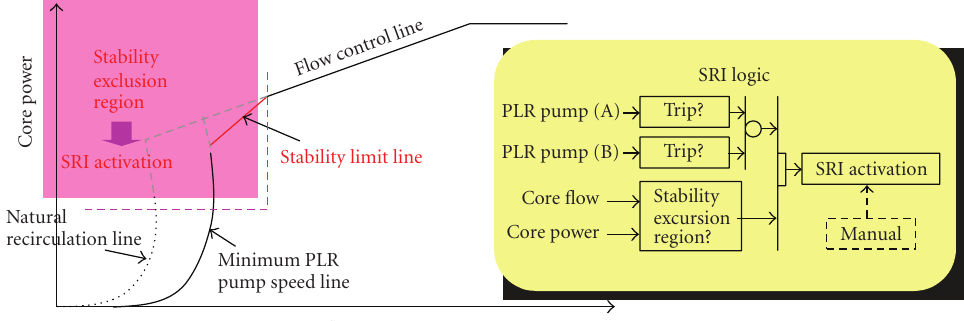
Figure 12: Outline of approved stability solution methodology in